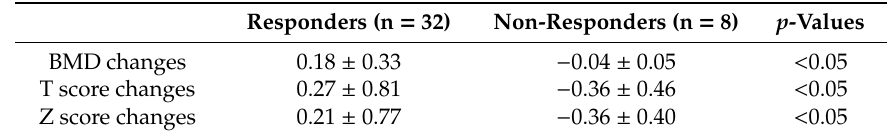
Table 2. Comparison of therapeutic responses between responders and non-responders after six-month treatment of Cinacalcet.